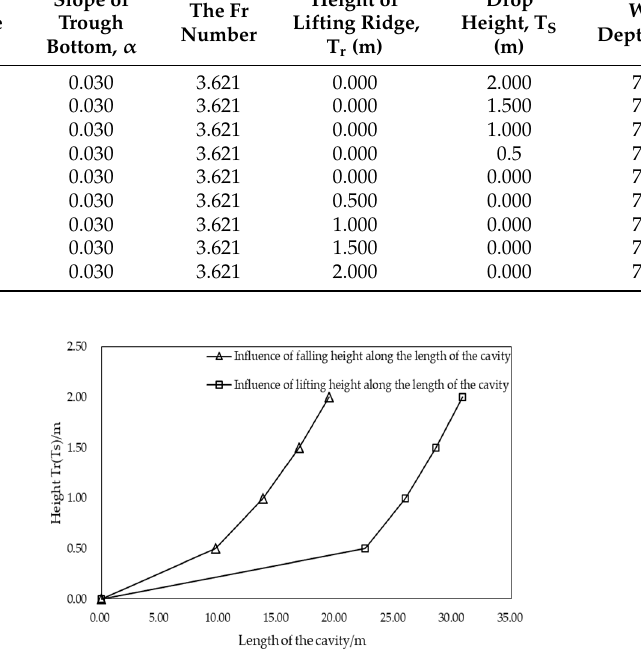
Figure 3. Relationship between different lifting and cavity length.